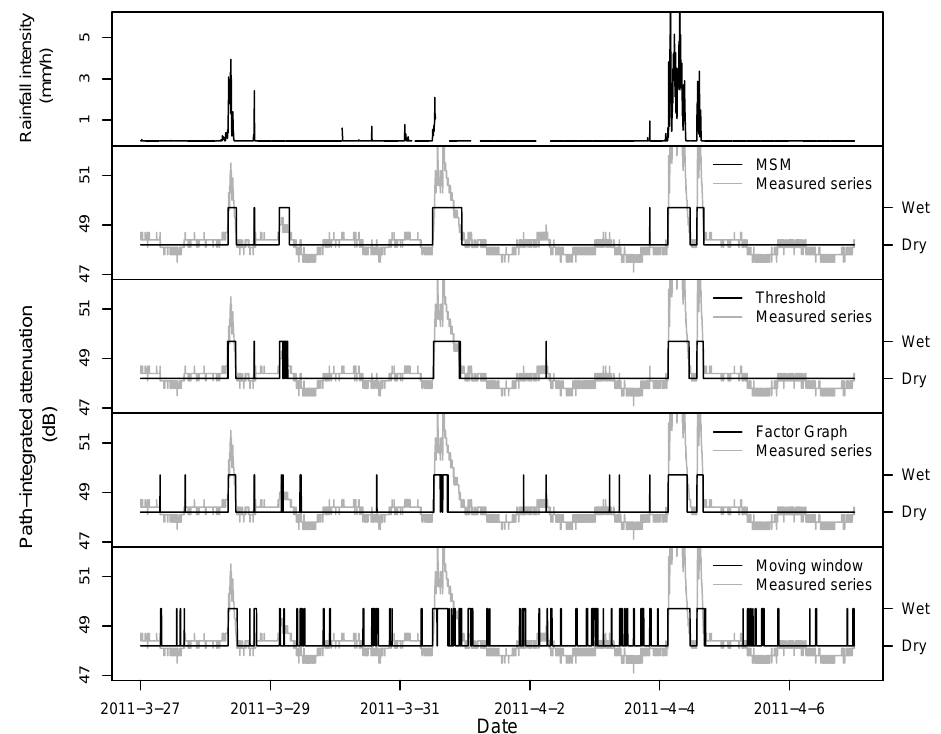
Fig. 4. Illustration of the classification performances of the algorithms on a subset of dataset 2 (non-stationary case). Displayed are the